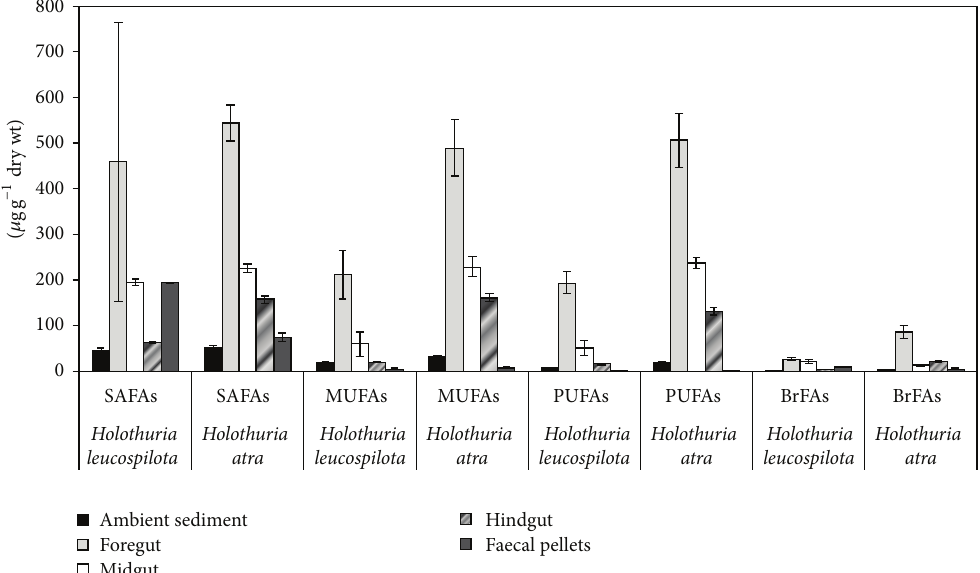
Figure2:ConcentrationofSAFAs,MUFAs,PUFAs,andBrFAsinambientsediment,foregut,midgut,hindgut,andfaecalpelletsof Holothuria atra and Holothuria leucospilota . Values are means ( ± SD).